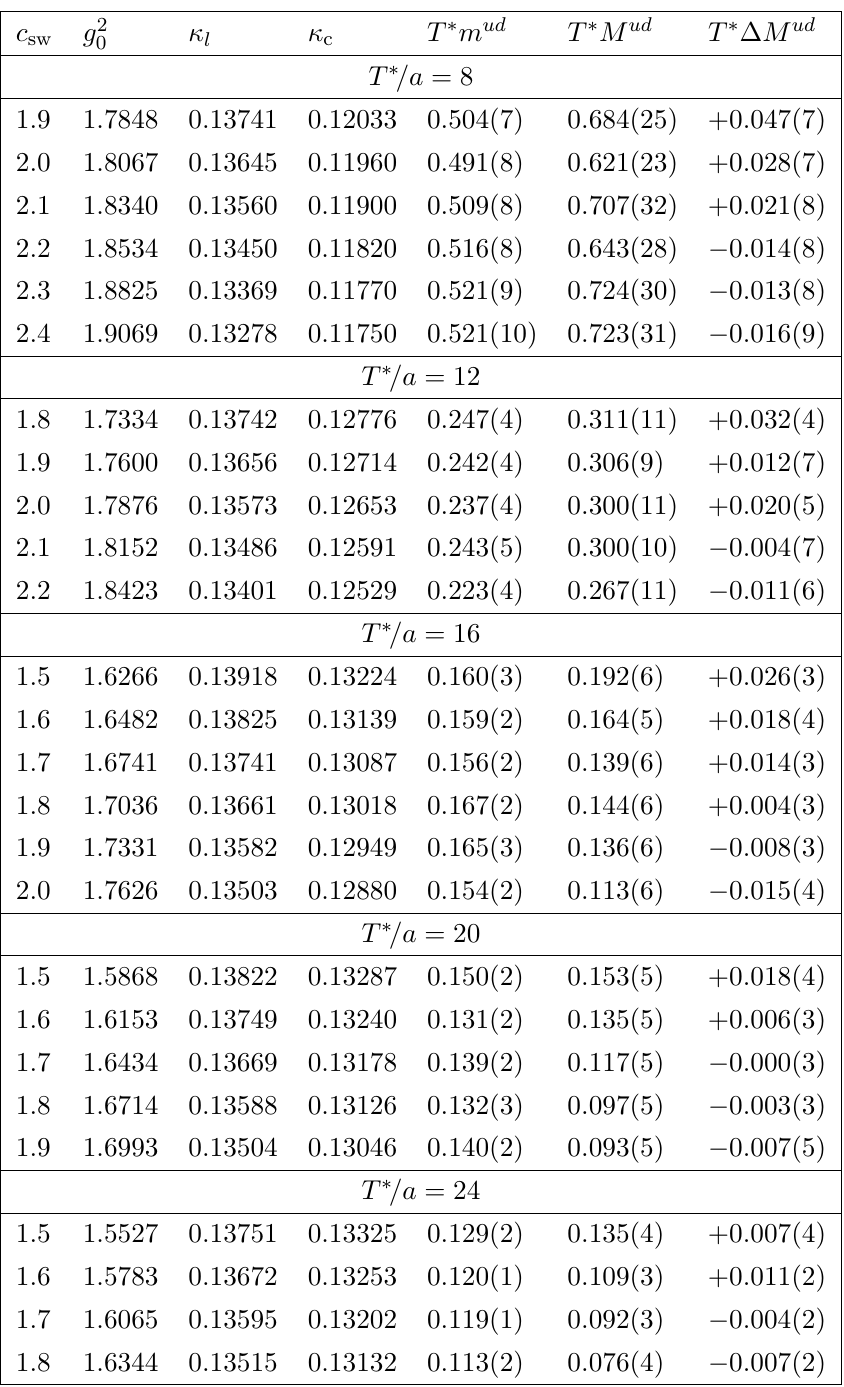
Table 2 . Results of the individual improvement condition runs along the LCP for various input values of c sw . Beside g 0 , (cid:20) l and (cid:20) c , we quote the corresponding current quark masses m ud ( x 0 )